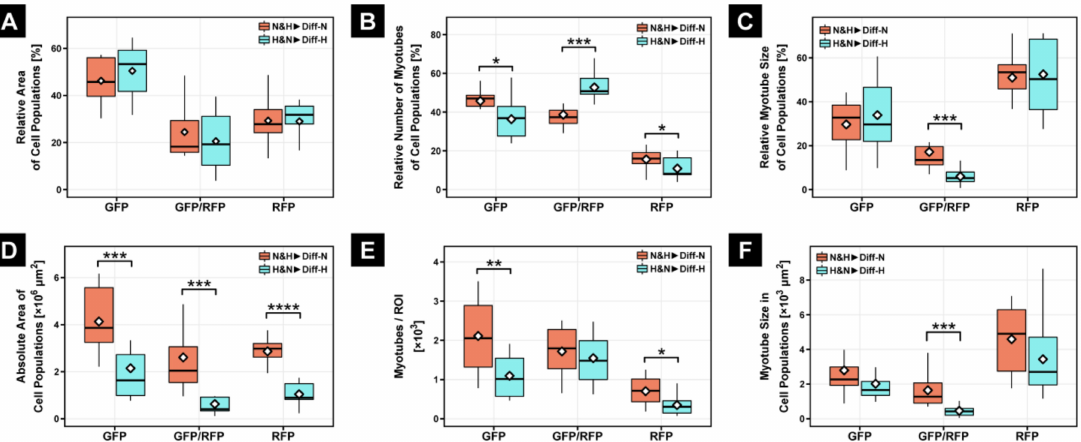
Figure 6. Within the subpopulation, there was no significant difference in relative area of cell popula- tion ( A ); however, quantification of the absolute area of all subpopulations at 21% O 2 (N&H (cid:183) Diff-N) showed a significant increase compared with H&N (cid:183) Diff-H ( D ). While the relative number of mixed myotubes under hypoxic differentiation condition (H&N (cid:183) Diff-H) revealed a significant increase in double-fluorescent myotubes compared with differentiation in normoxia (N&H (cid:183) Diff-N; B ), the absolute number of myotubes did not show similar results ( E ). The size of myotubes at 21% O 2 was significantly greater within mixed myotubes, regardless of absolute or relative view, when compared with the H&N (cid:183) Diff-H group ( C , F ). Bar plots represent the median, quartiles, range, and mean (white diamond). * p ≤ 0.05. ** p ≤ 0.01. *** p ≤ 0.001. **** p ≤